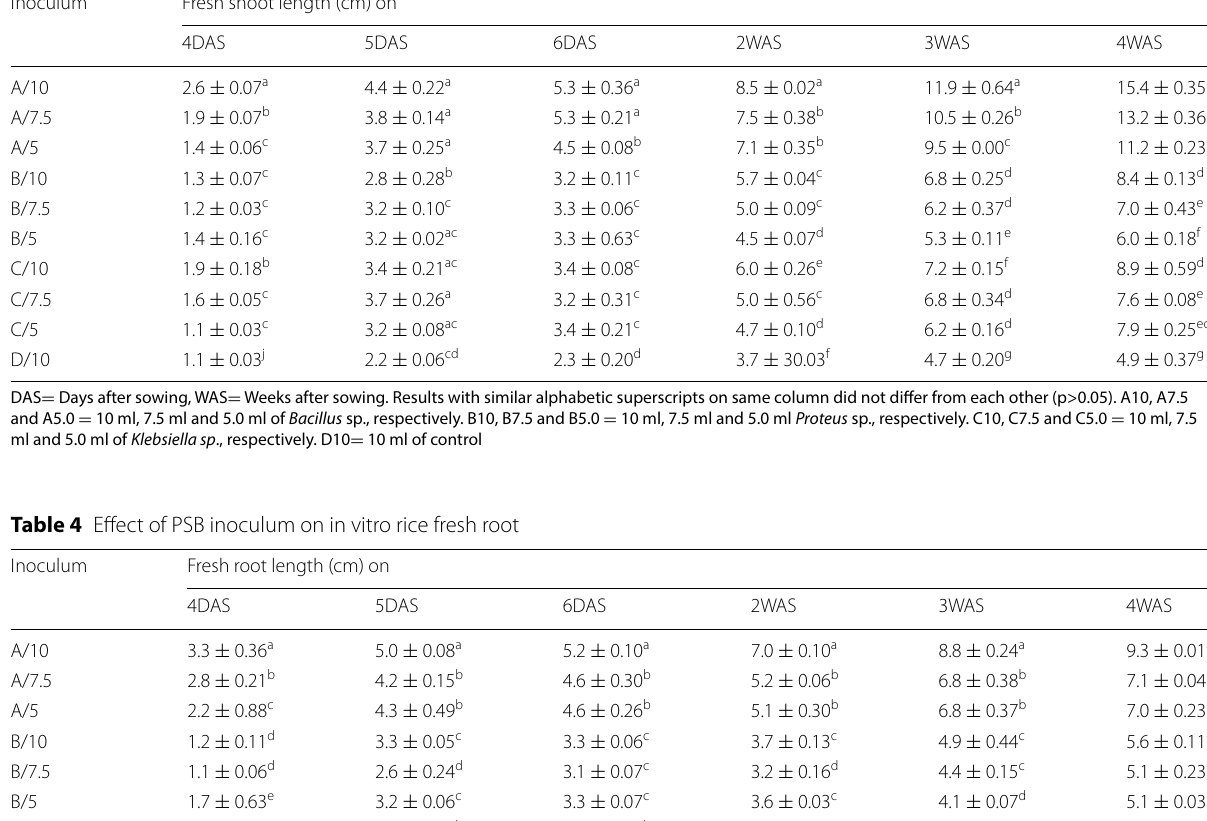
Table 3 Effect of PSB inoculum on in vitro rice fresh shoot length